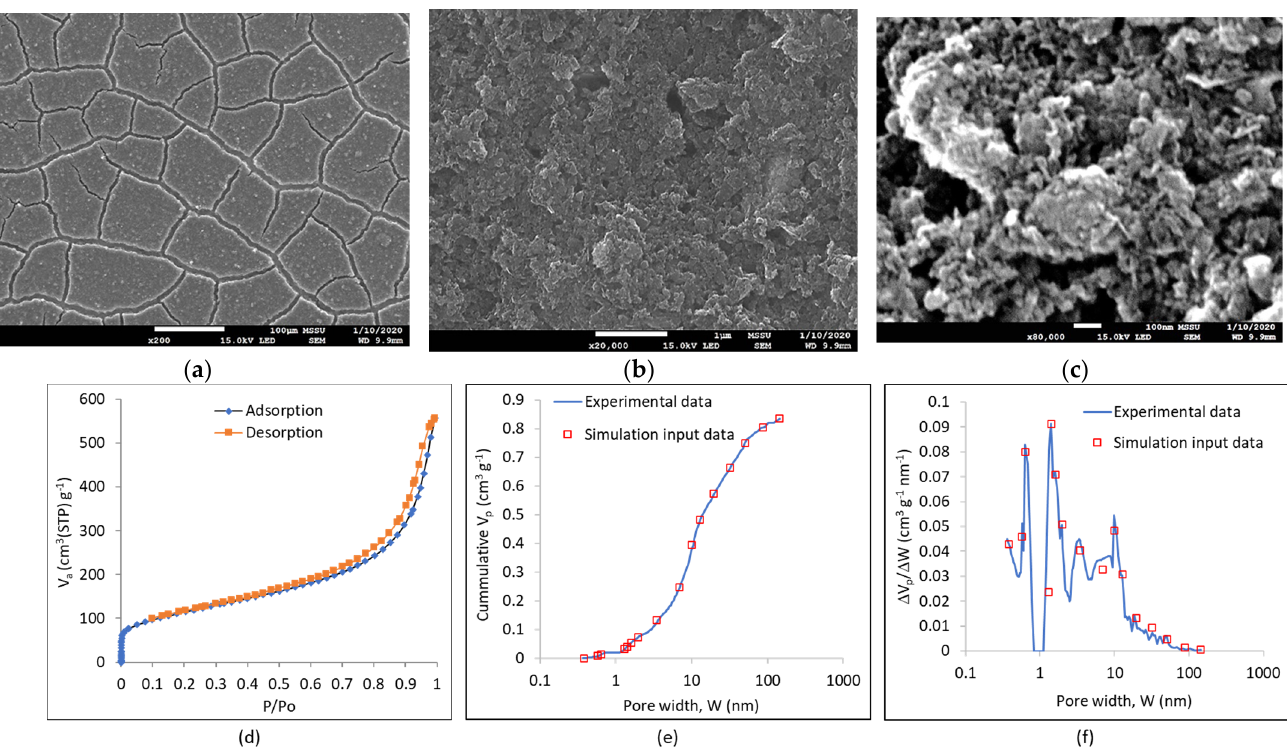
Figure 5. Results from the characterisation of electrode coating. ( a – c ) SEM images of the electrode coating at three different magnifications, sequentially: scale bar: 100 μ m, 1 μ m, 100 nm; ( d – f ): results of the nitrogen adsorption/desorption tests for the characterization of the electrode coating: ( d ) experimental data of adsorption/desorption isotherms; ( e ) cumulative pore size distribution graph; ( f ) incremental pore size distribution graph.